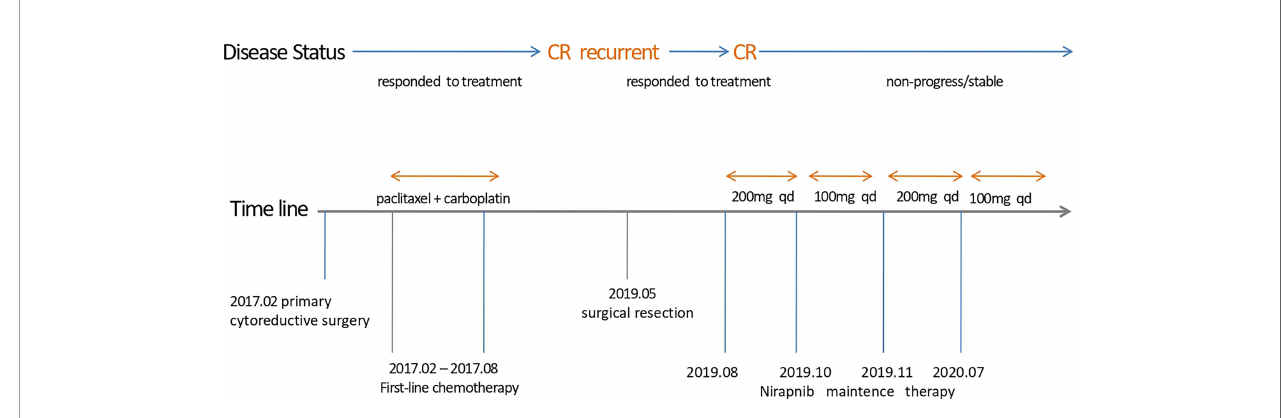
FIGURE 1 | Timeline of different treatments and disease